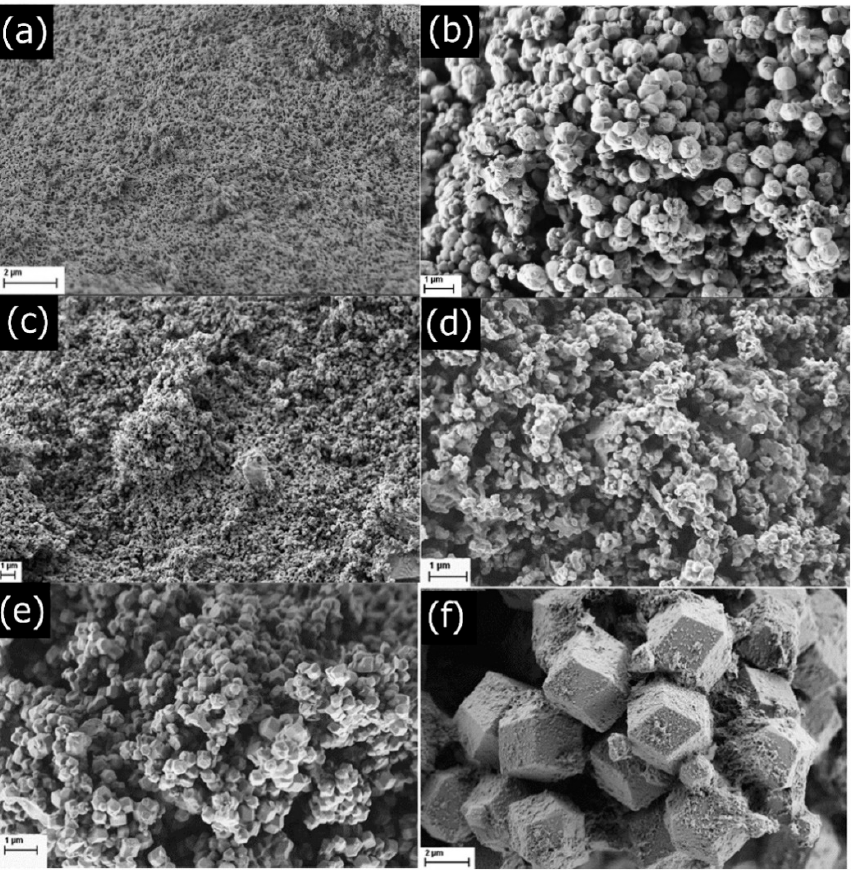
Figure 2. SEM images of the synthesised ZIF-90: ( a ) ZIF-90-D, ( b ) ZIF-90-C, ( c ) ZIF-90-2G, ( d ) ZIF-90-G, ( e ) ZIF-90-GM and ( f ) ZIF-90-G2M.